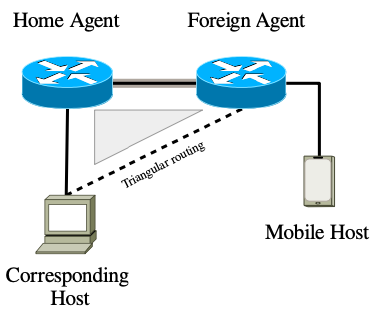
Figure 3. Mobile IPv4